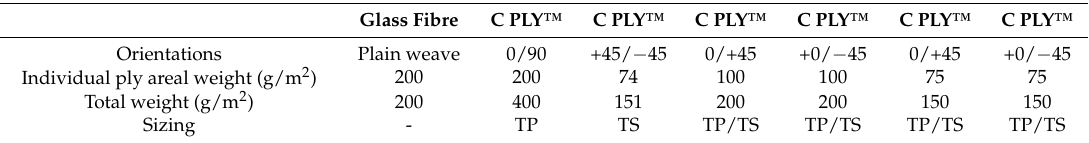
Table 1. Fabric Reinforcement used in current research.